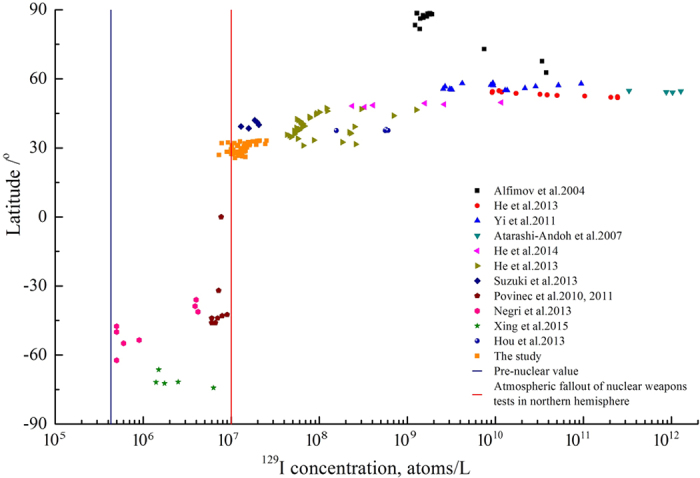
Comparison of 129I concentrations in surface seawater from the ECS and other locations.